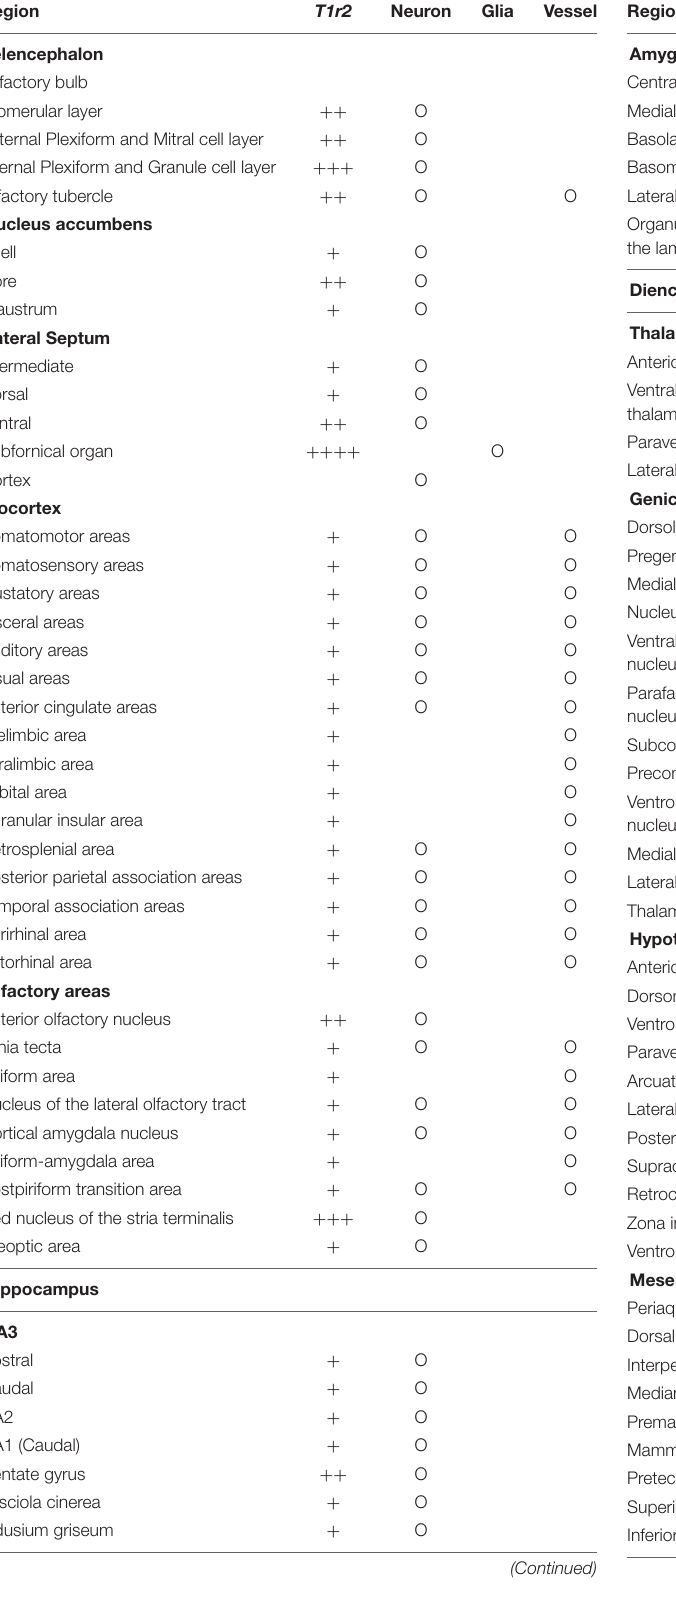
TABLE 3 | Anatomic mapping of T1r2 -expressing brain area. Region